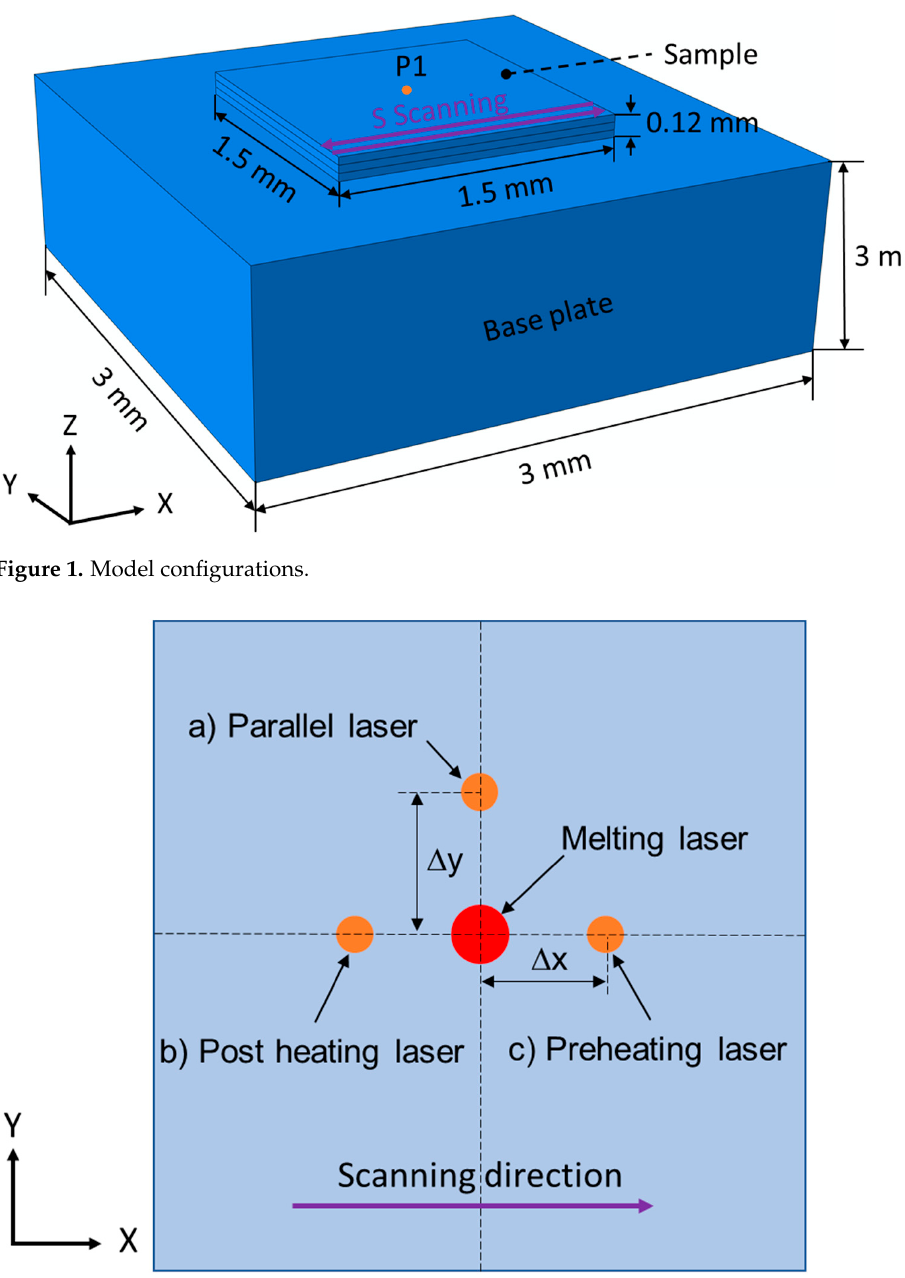
Figure 2. Illustration of three different modes of a secondary laser beam: ( a ) parallel mode; ( b ) post ‐ heating mode; and ( c ) preheating mode.